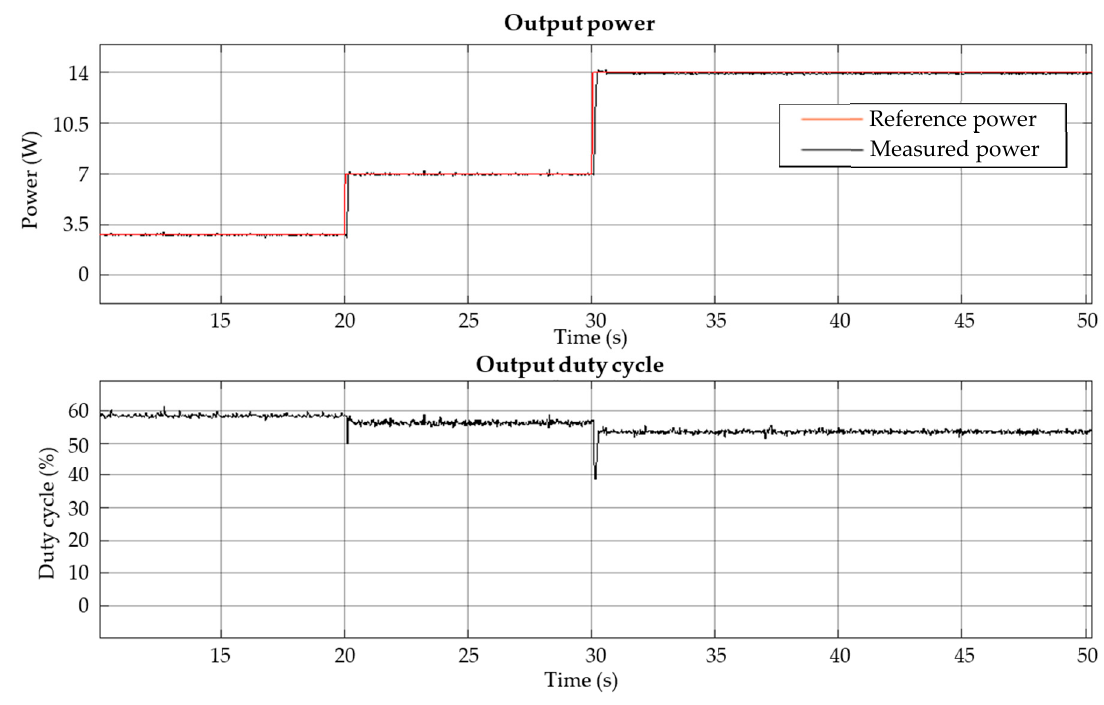
Figure 12. Output power response of the fuzzy logic controlled boost converter as the reference power is stepped from 2.8 W to 7 W at t = 20 s and from 7 W to 14 W at t = 30 s. The rise time for the measured power as the reference power is stepped at t = 30 s is approximately 110 ms with 2.4% overshoot. The fuzzy logic controller’s performance was deemed to be su ffi cient